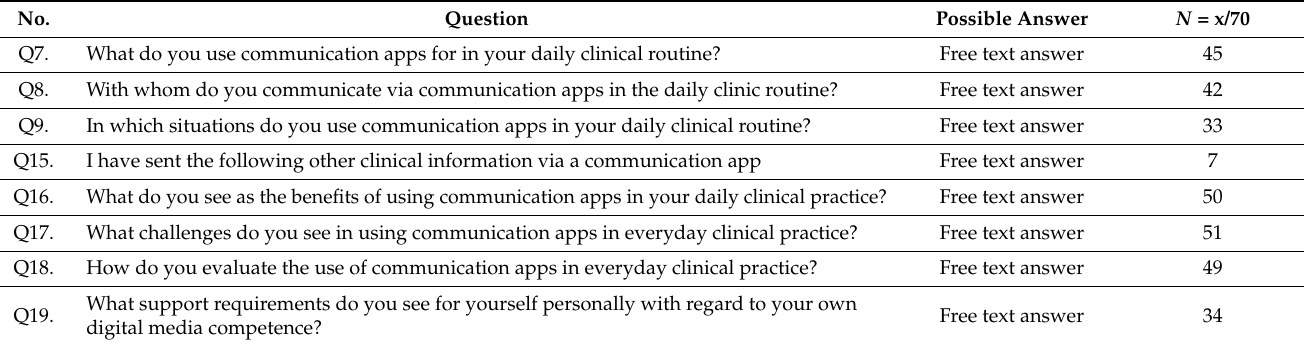
Table 2. Number of free-text responses received per open-ended question.